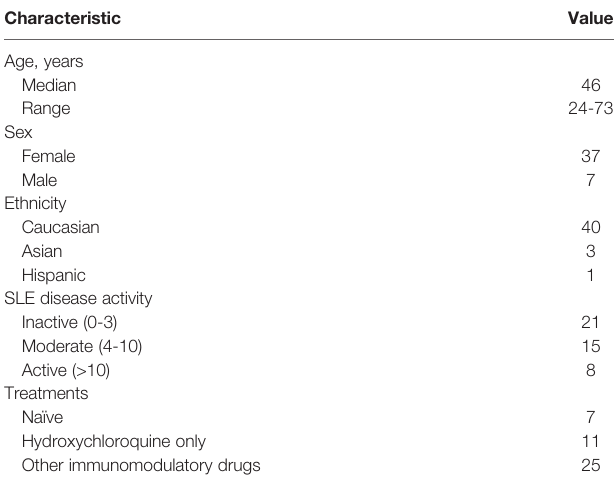
TABLE 1 | Demographic characteristics of SLE patients (N=44) included in the